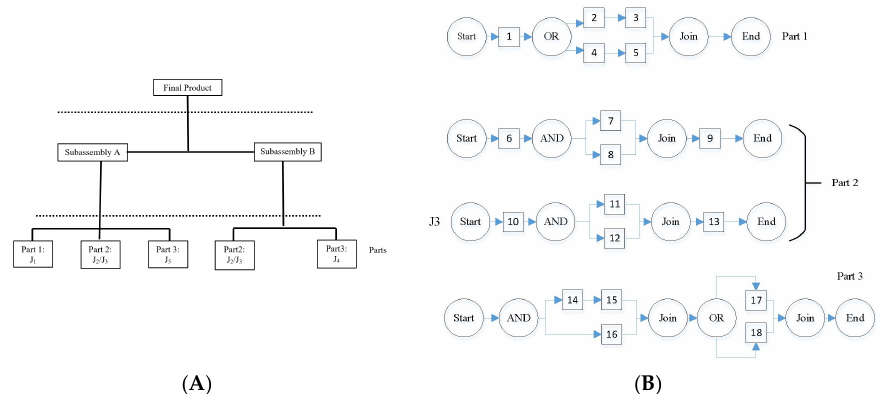
Figure 19. ( A ) An example of a flexible assembly job shop scheduling problem with three parts, two subassemblies. ( B ) AND/OR graph of machine operations of parts with alternative process plans [148].